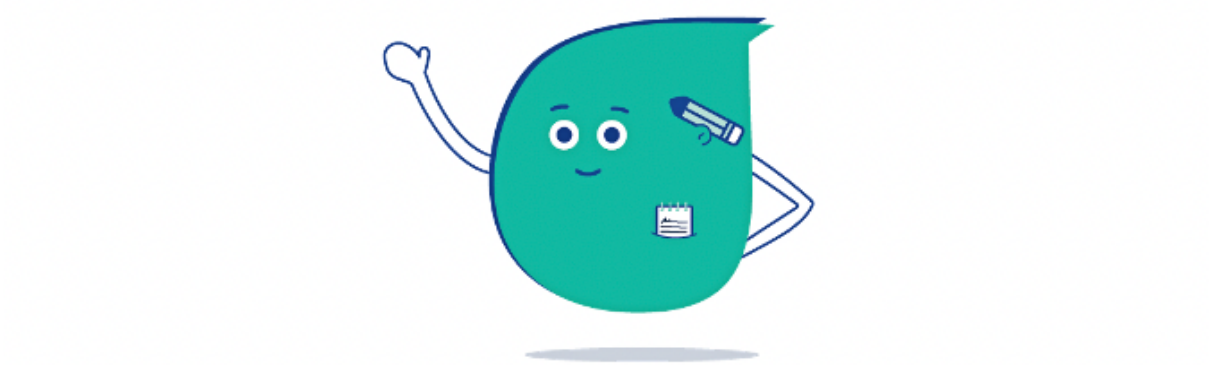
Figure 4. The main pose for the chatbot character of